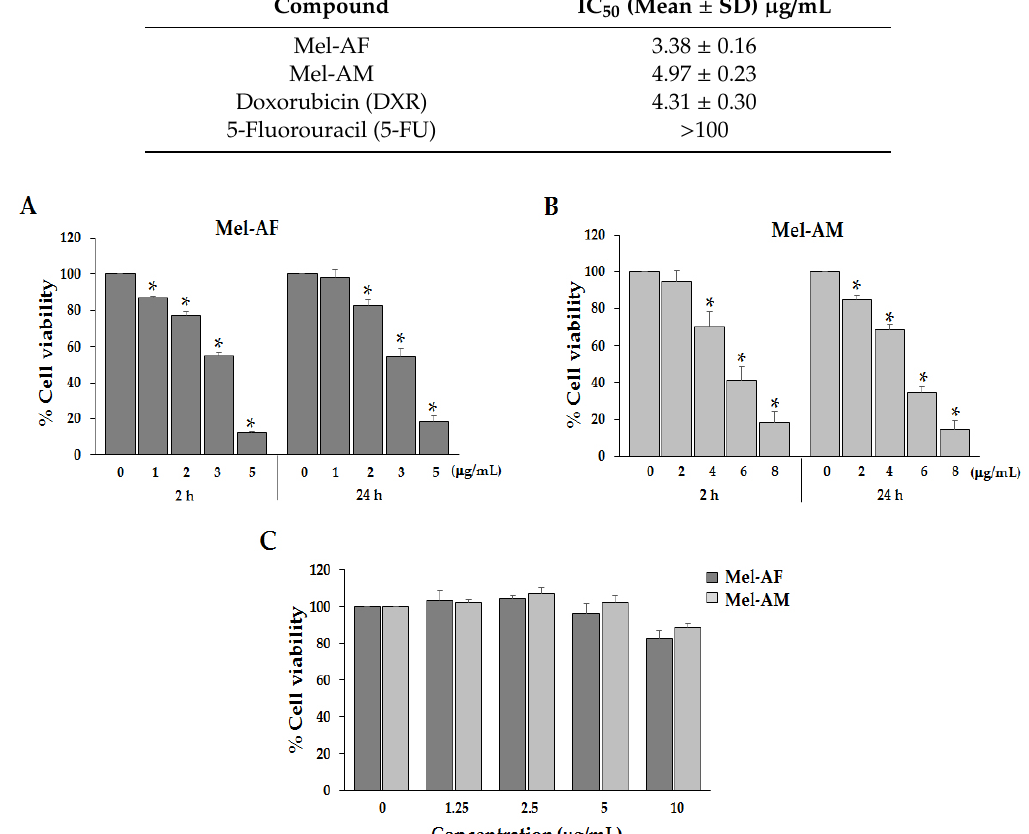
Figure 2. Effect of Mel-AF on A375 cell and NIH-3T3 cell viability. The cells were treated with the indicated concentration of Mel-AF (or Mel-AM) for 2 and 24 h. The viable cells after treatment were determined by MTT assay. ( A,B ) Anti-proliferative effects of Mel-AF compared to Mel-AM on A375 cells. ( C ) Non-cytotoxic effects of Mel-AF and Mel-AM on NIH-3T3 cells. Data are presented as mean ± SEM values of three independent experiments that were performed in triplicate. * p < 0.05 was determined by one-way analysis of variance.